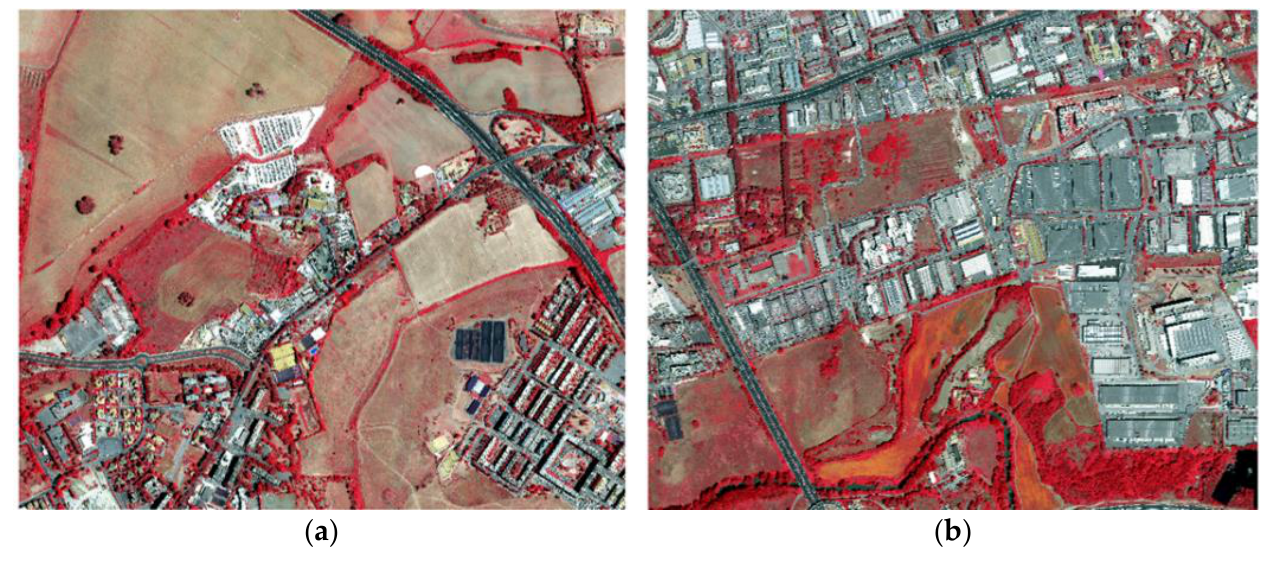
Figure 2. ( a ) Training area; ( b ) validation area.